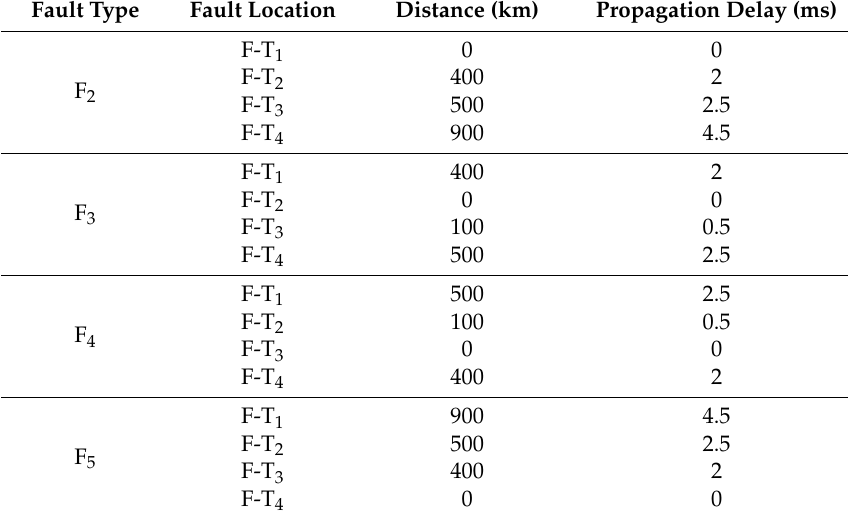
Table 3. Different fault scenarios.